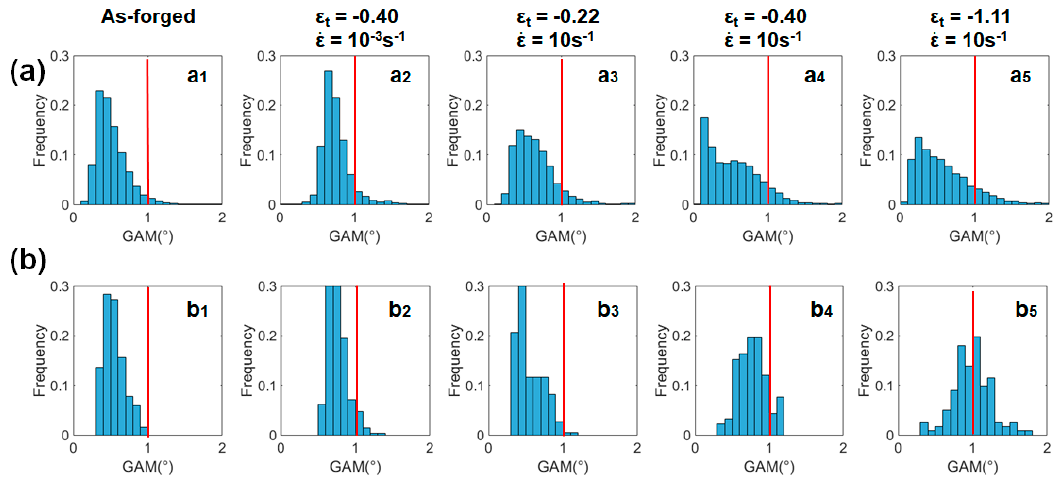
Figure 11. GAM histogram plots derived from EBSD data for: ( a ) all grains and ( b ) sheared coarse grains as the cyan group under varied conditions including the as-forged state, deformed states with ε t of − 0.22 at 10 − 3 s − 1 and with ε t of − 0.22, − 0.40 and − 1.11 at 10 s − 1 .